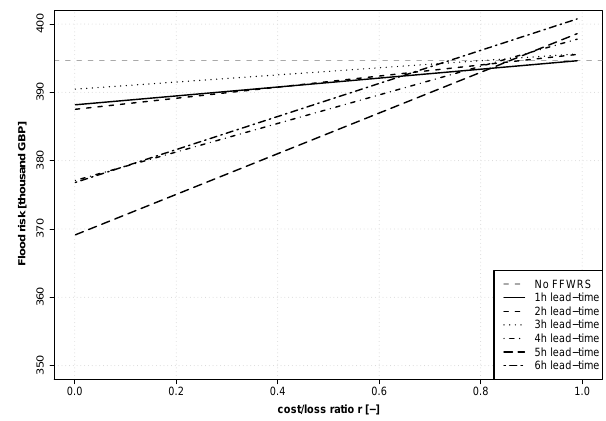
Fig. 7. Flood risk as a function of cost-loss ratio and lead-time in the Deterministic Forecasts